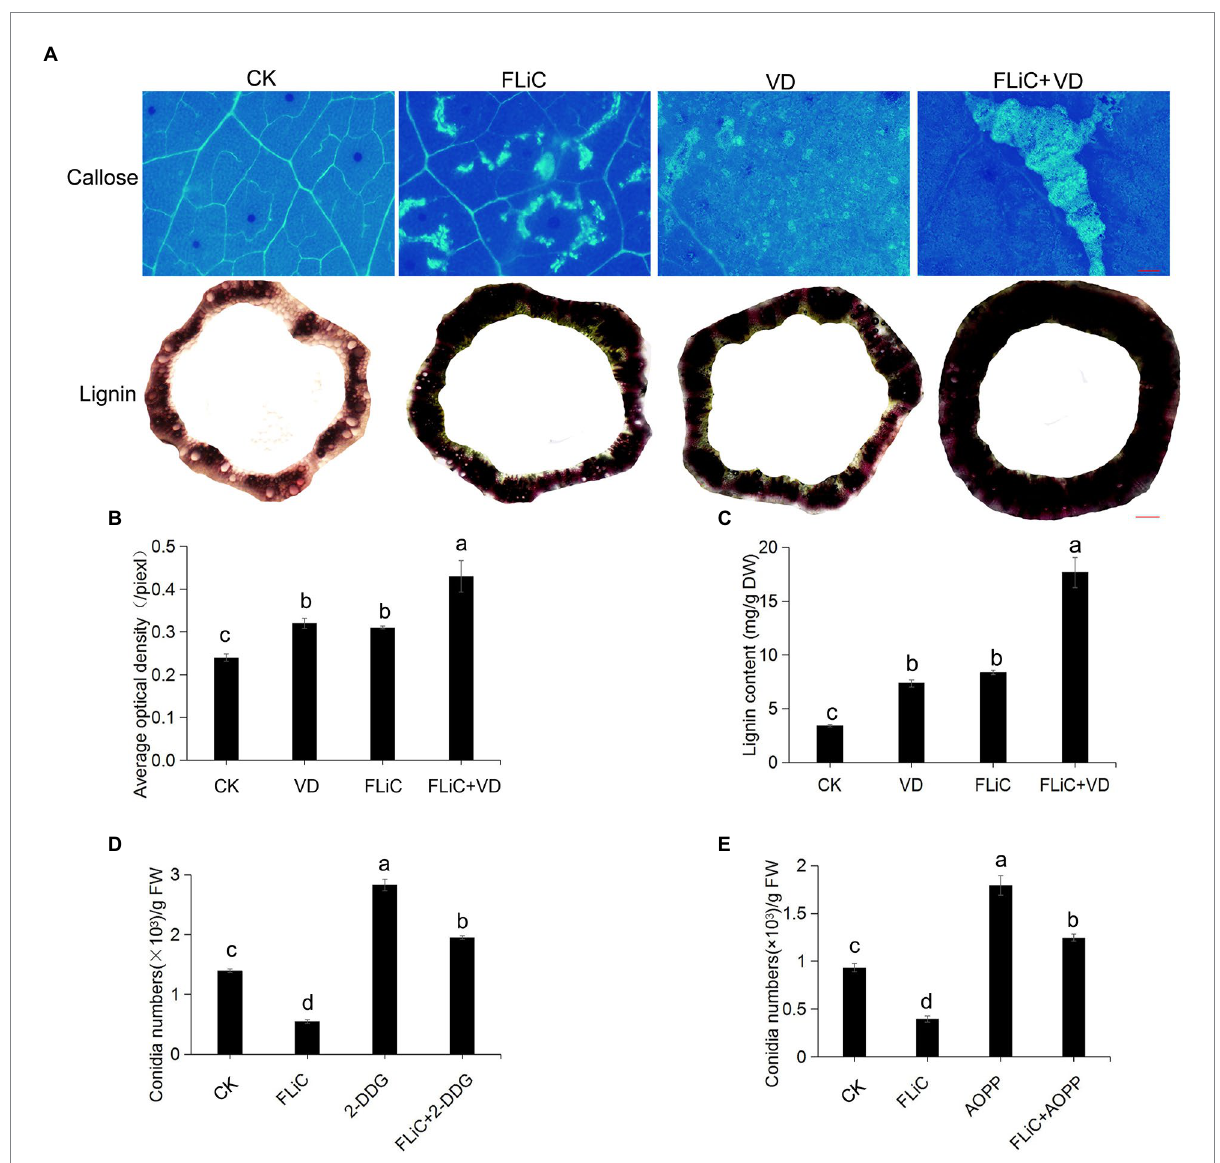
FIGURE 3 FLiC induces the deposition of lignin and callose in upland cotton. (A) FLiC induced the deposition of leaf callose and stem lignin in cotton (callose bars = 1,000 μ m; lignin bars = 2,000 μ m). The concentration of FLiC was 100 μ g/ml, and the cotton leaves were treated for 48 h. (B) Statistics of the average optical density of callose. (C) Determination of the lignin content. (D) Statistics of the bacterial mass after the clearance of callose with 2-DDG. (E) Statistics of the bacterial mass after the clearance of lignin with AOPP. The data represent the means ± SDs; n = 3. One-way ANOVA ( p < 0.05) followed by Duncan’s test was used for multiple comparisons. The different letters indicate significance at the 0.05 probability